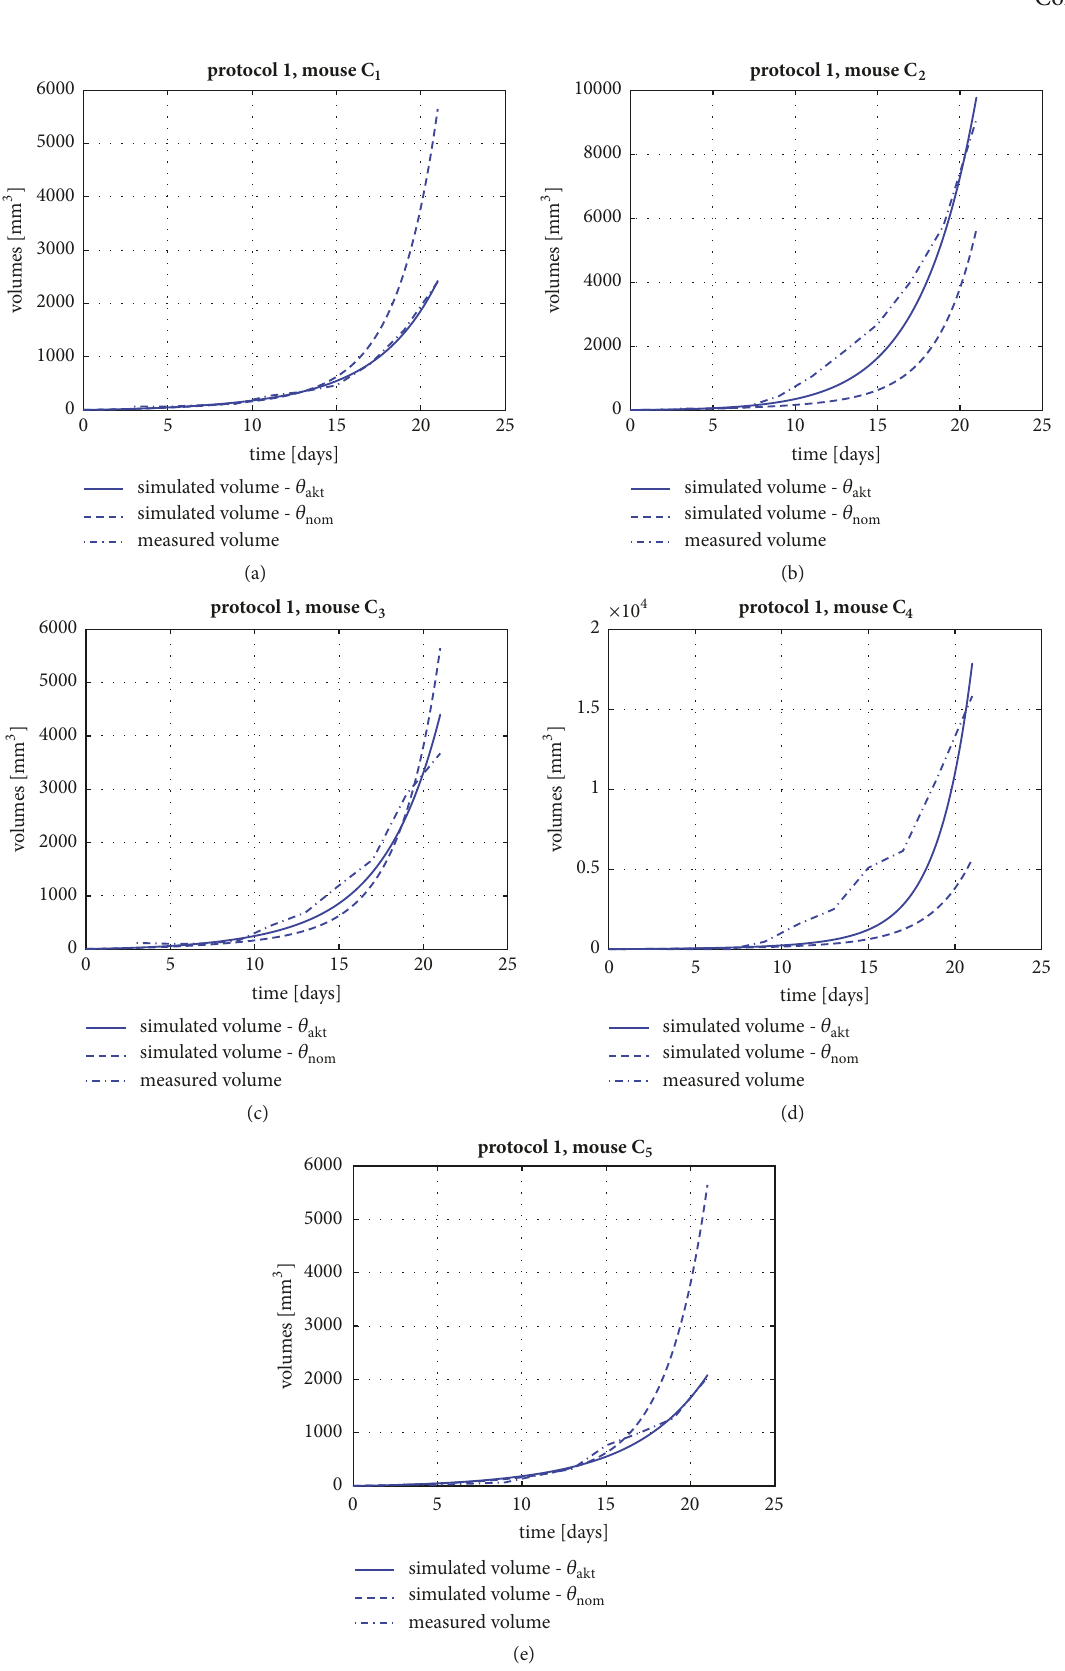
Figure 10: Fitting the model to individual trajectories in the case of therapy 1: simulated output (with the parameters obtained from fitting the model to the specific trajectory ( 𝜃 𝑎𝑘𝑡 ), simulated output with nominal parameters ( 𝜃 𝑛𝑜𝑚 ), and measured